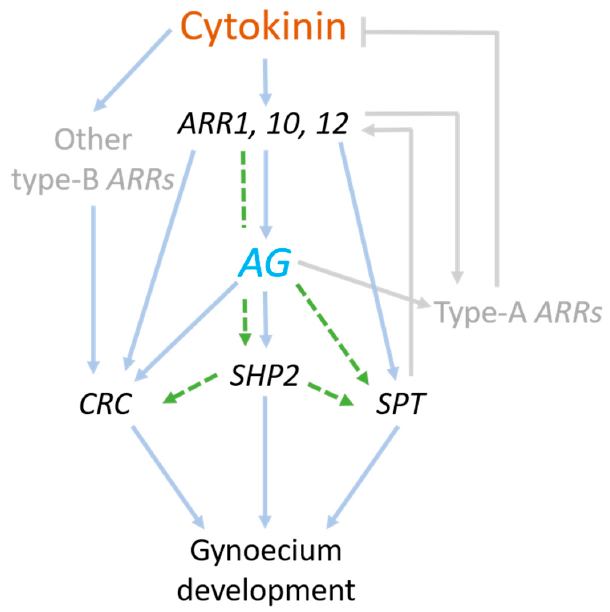
Figure 4. Model of a gene regulatory network of the relationship between AG , CRC , SPT , SHP2 , and cytokinin signaling during early gynoecium development. AG is important for gynoecium development, and contributes to regulating or directly regulates CRC , SHP2 , and SPT . All four genes respond to either reduced or induced cytokinin signaling. Cytokinin-mediated induction of AG and SPT is dependent on type-B ARR proteins (ARR1, ARR10, ARR12). The SHP2 gene responds to cytokinin in an AG-dependent manner and might be cooperatively regulated by AG and ARR1 in this condition. AG regulates type-A ARR genes, which negatively feedbacks to cytokinin signaling (in grey colored lines); a negative feedback loop is important for homeostasis. The second negative feedback loop is activated by the type-B ARR proteins. Green dashed lines are suggested interactions and might be direct or indirect regulatory interactions. Not indicated, but all transcription factors are also regulated by other factors.